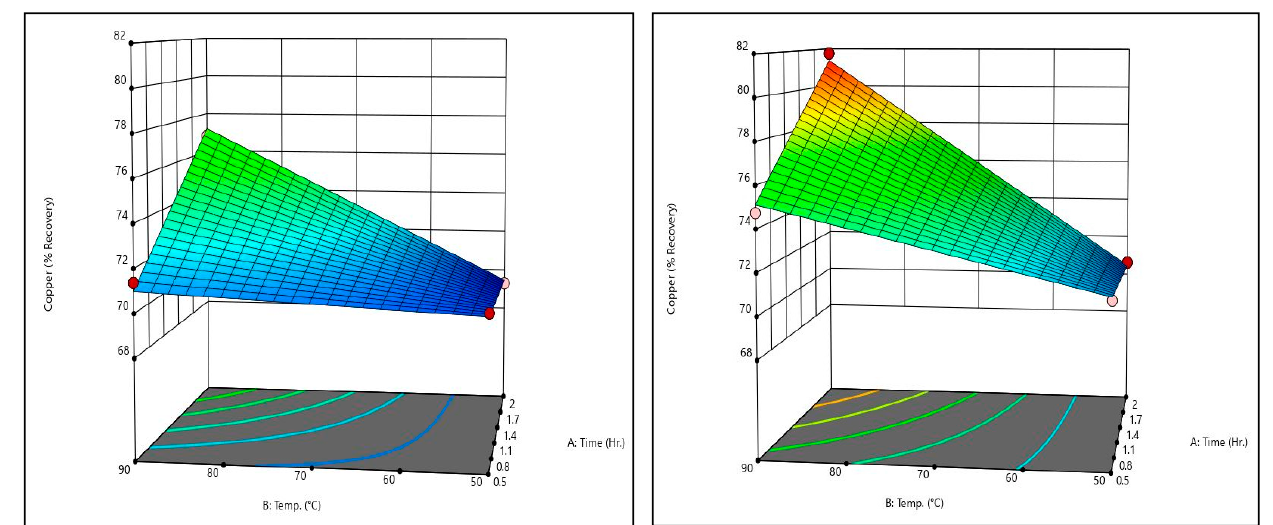
Figure 10. Sulfurous acid copper recovery response surfaces: low acid ( left ) and high acid ( right ).